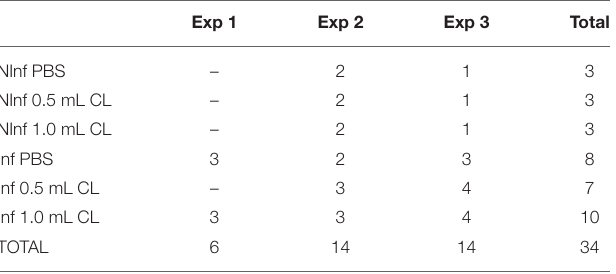
TABLE 1 | Number of Saimiri sciureus monkeys used per